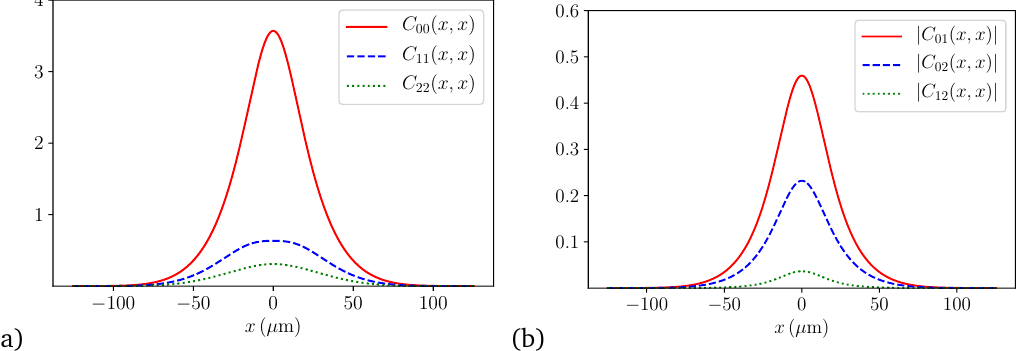
( x , y ) of interest, with the ij